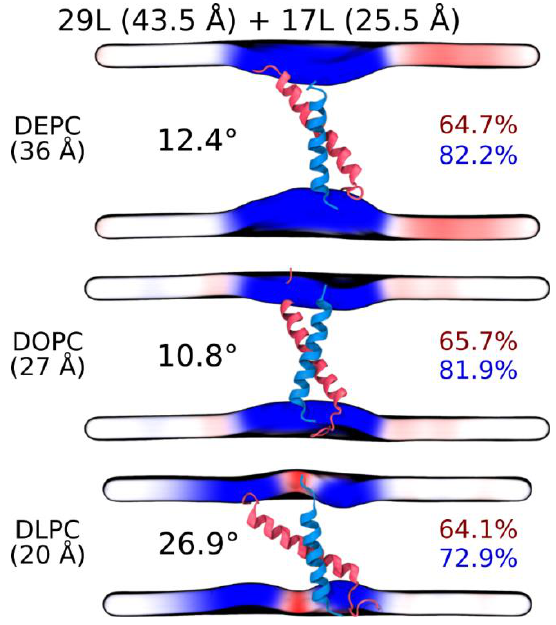
FIGURE 9: Summary of the results from MD simulations of the 17L/29L hetero-dimer. Coloring and organization as in Figure 3, ex- cept that the alpha-helical contents are given separately for the two